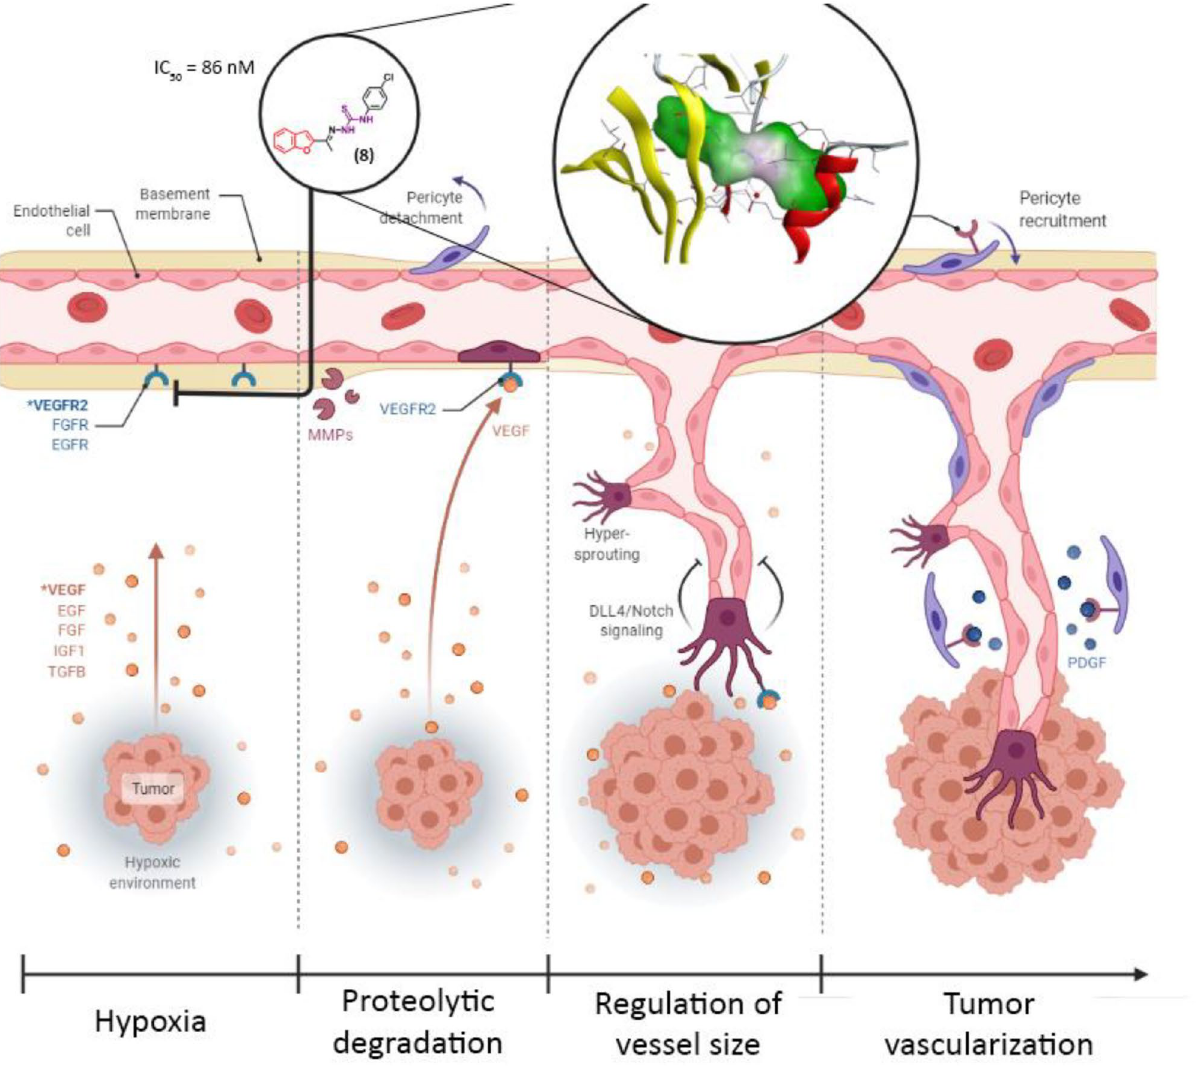
Figure 13. Illustration of inhibitory mechanism of compound 8 on VEGFR-2